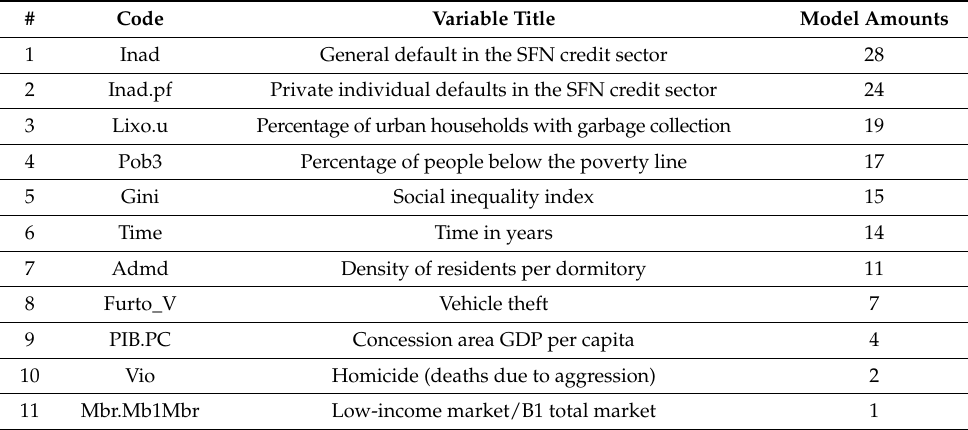
Table 4. Results of the set of explanatory variables.